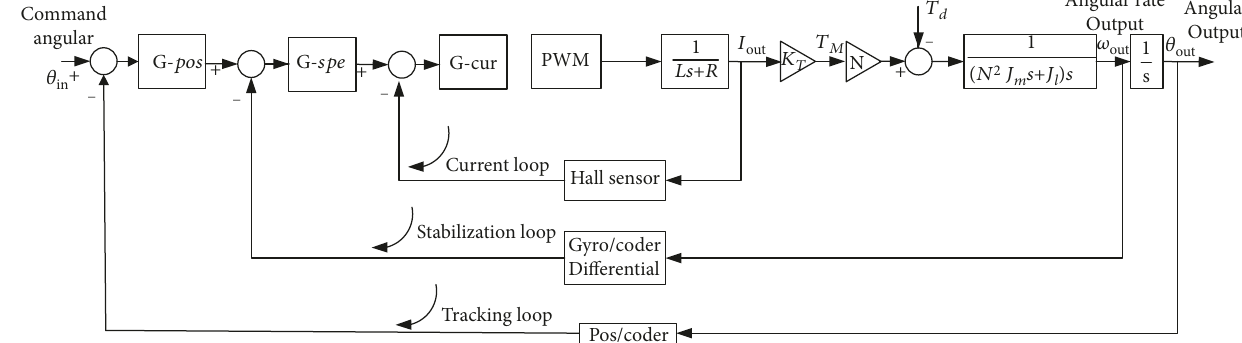
Figure 3: A block diagram of a traditional three-loop control system for the ISP.